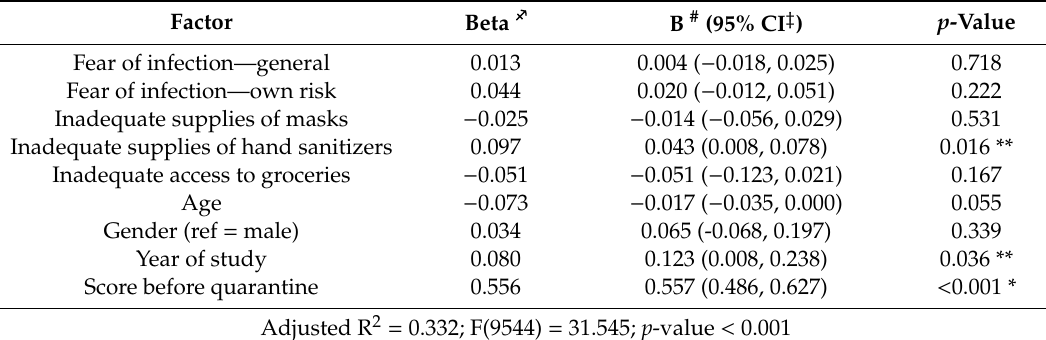
Table 4. Linear regression model of negative a ff ect (PANAS-NA) ( n = 555). Factor Beta